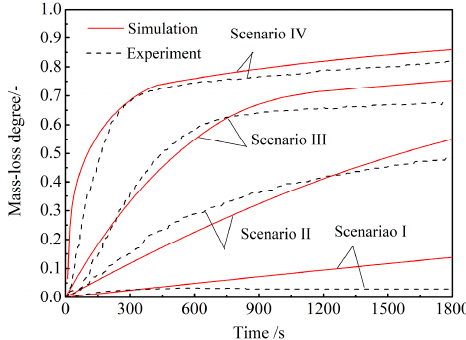
Figure 7. Comparison of the mass-loss degree curves between the model predictions and the experiments. Table 5. Measured and model-predicted parameters of CCB after reacting for 30 min.